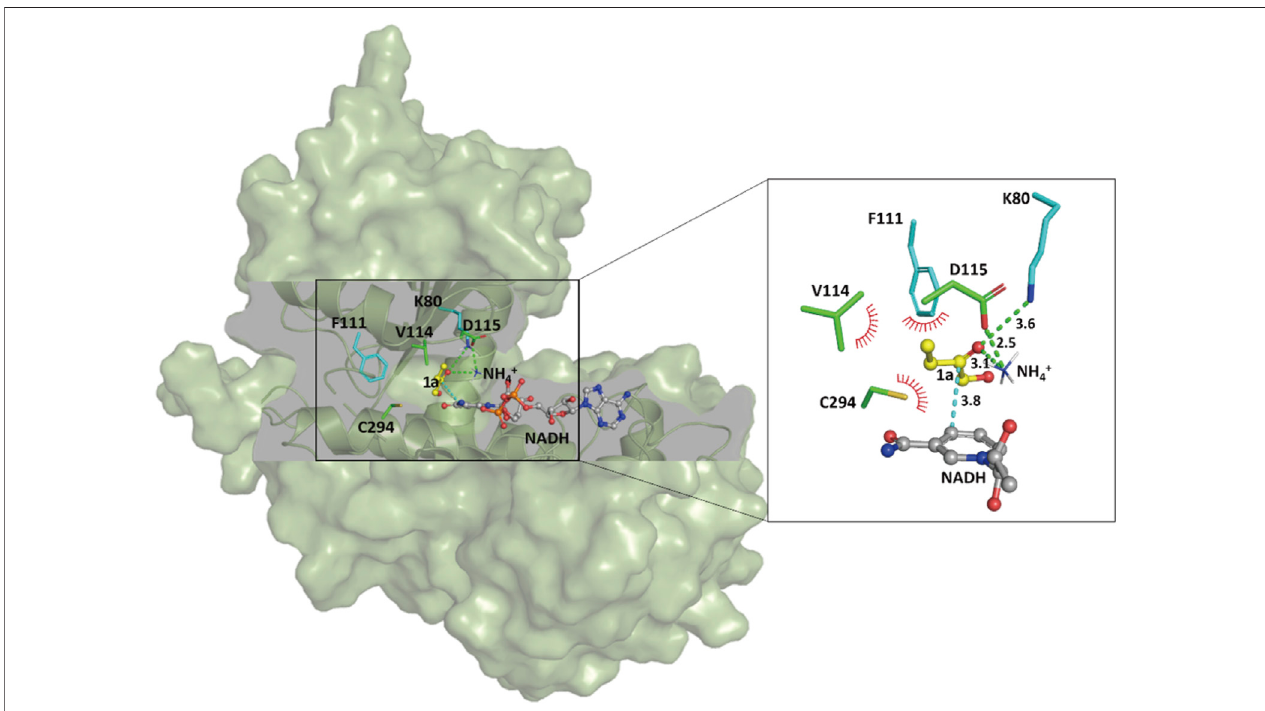
FIGURE5| Dockinganalysisofsubstrate1ainthecatalyticpocketofthe Sp AmDHvariantwh84.Greenlinesandredspikesrepresentthehydrogenbondsandthe penitential hydrophobic interactions, respectively. The cyan line indicates the nucleophilic attack. Distances are shown in angstroms.